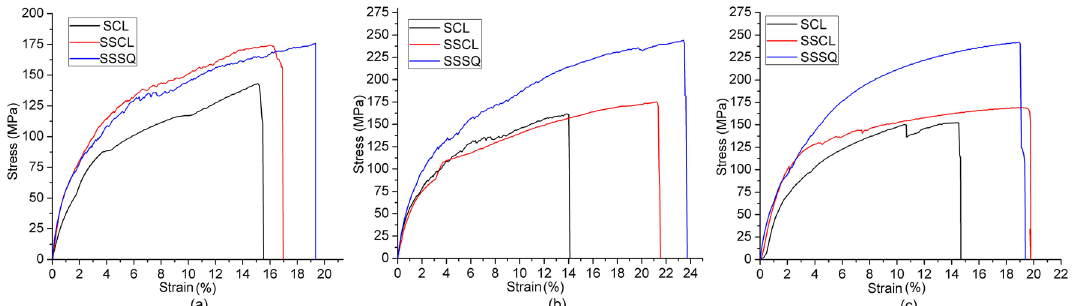
Figure 4. Stress- Strain curve in the SZ at (a) 800 rpm (b) 1000 rpm (c) 1200 rpm. Scrolled Cylindrical (SCL), Scrolled Stepped Cylindrical (SSCL), and Scrolled Stepped Square (SSSQ)